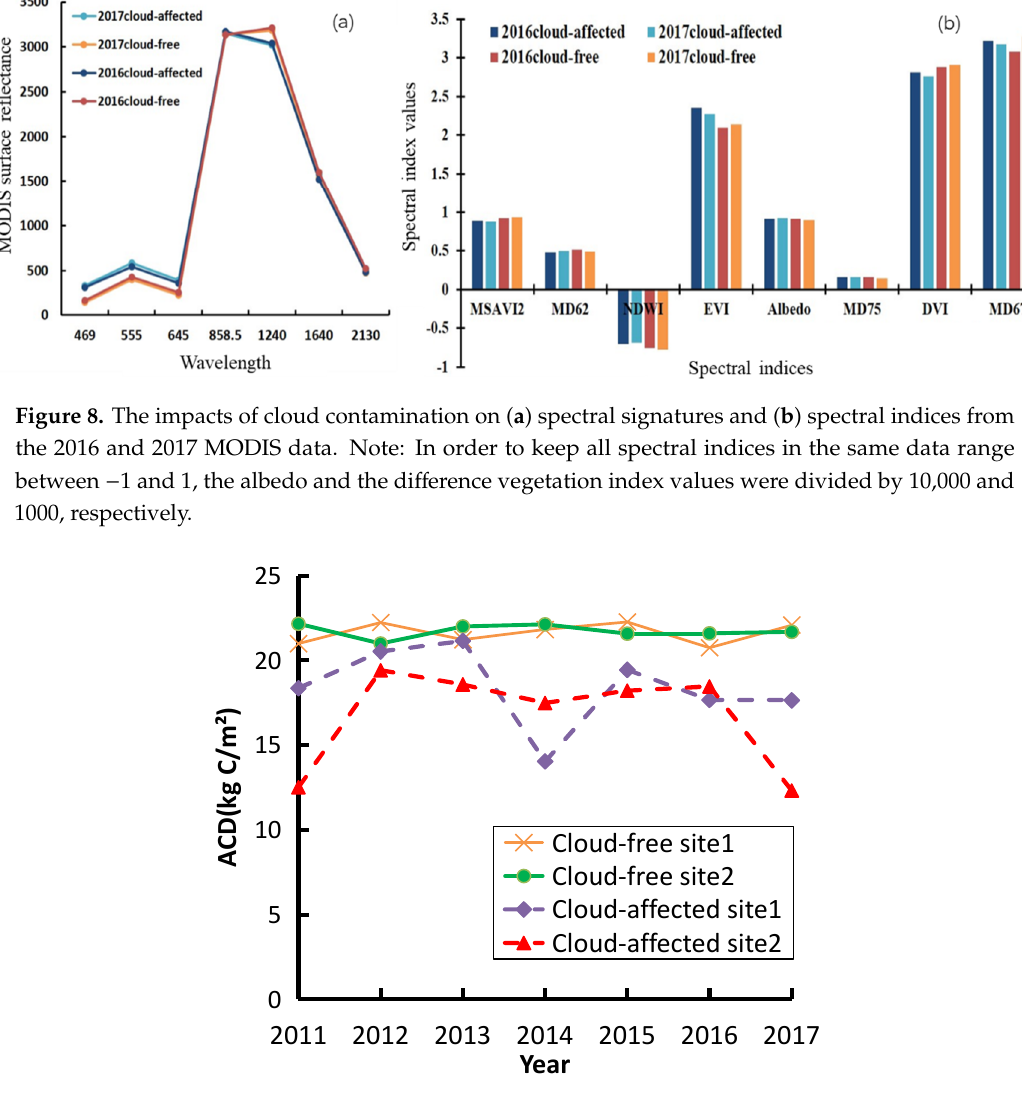
Figure 9. A comparison of predicted annual aboveground carbon density (ACD) for 2011–2017 with cloud-free and cloud-contaminated pixel conditions.